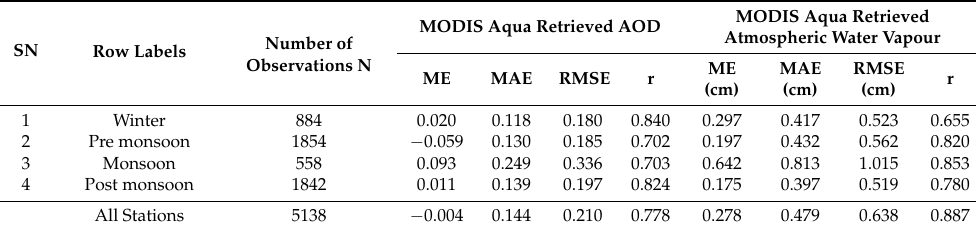
Table 6. Evaluation of MODIS Aqua derived AOD and precipitable water vapour against AERONET measured AOD and atmospheric water vapour in four seasons in the